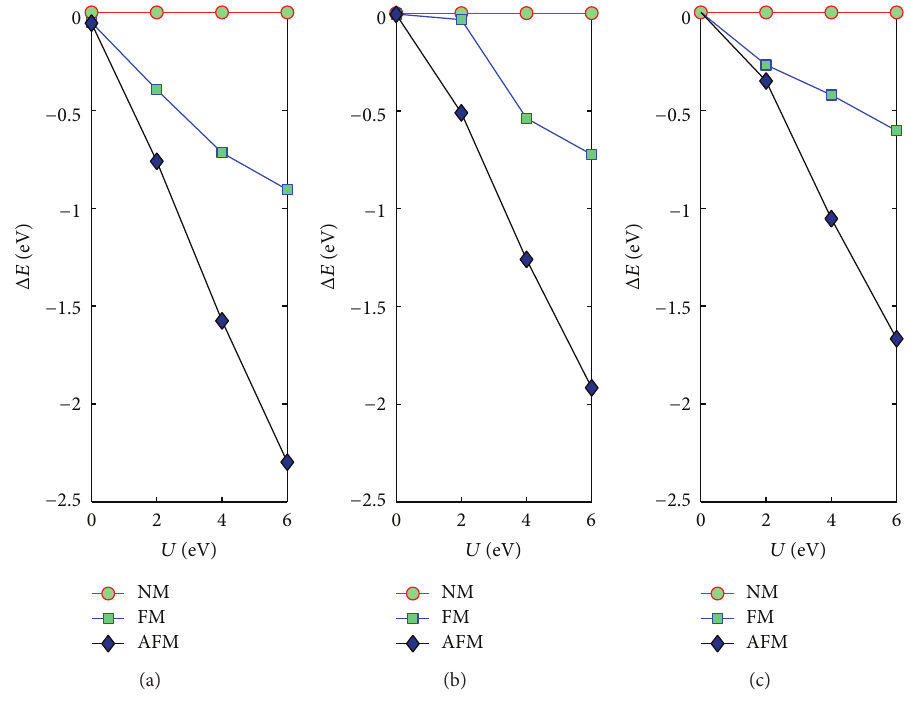
Figure 1: The difference in energy of the different magnetic configurations as function of 𝑈 for (a) CeS, (b) CeSe, and (c) CeTe.